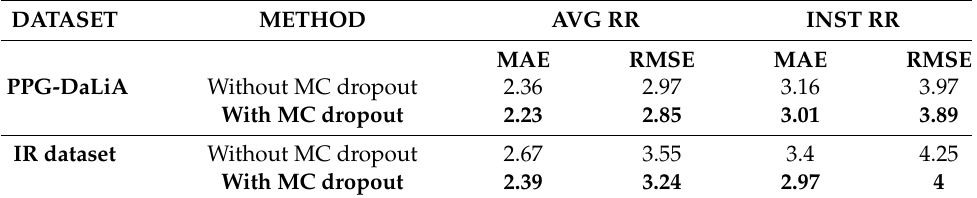
Table 4. Description of error reduction due to application of Monte Carlo dropout for both